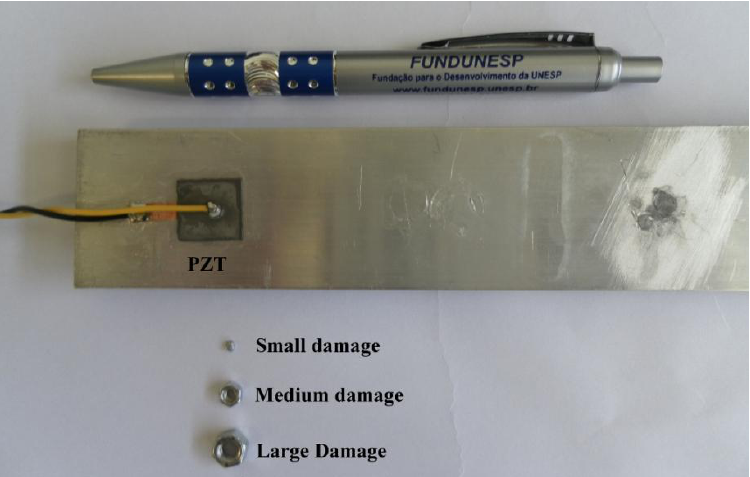
Figure 3. Aluminum beam with the PZT patch and damage of different